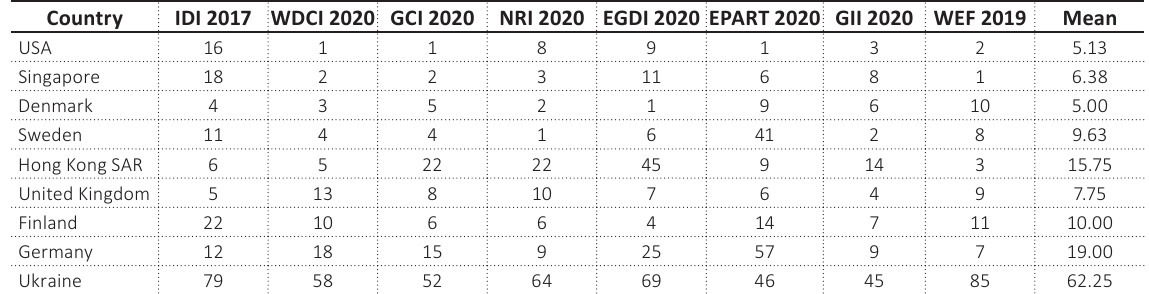
Table 2. Changes in the place of countries in the ranking of digital competitiveness Country